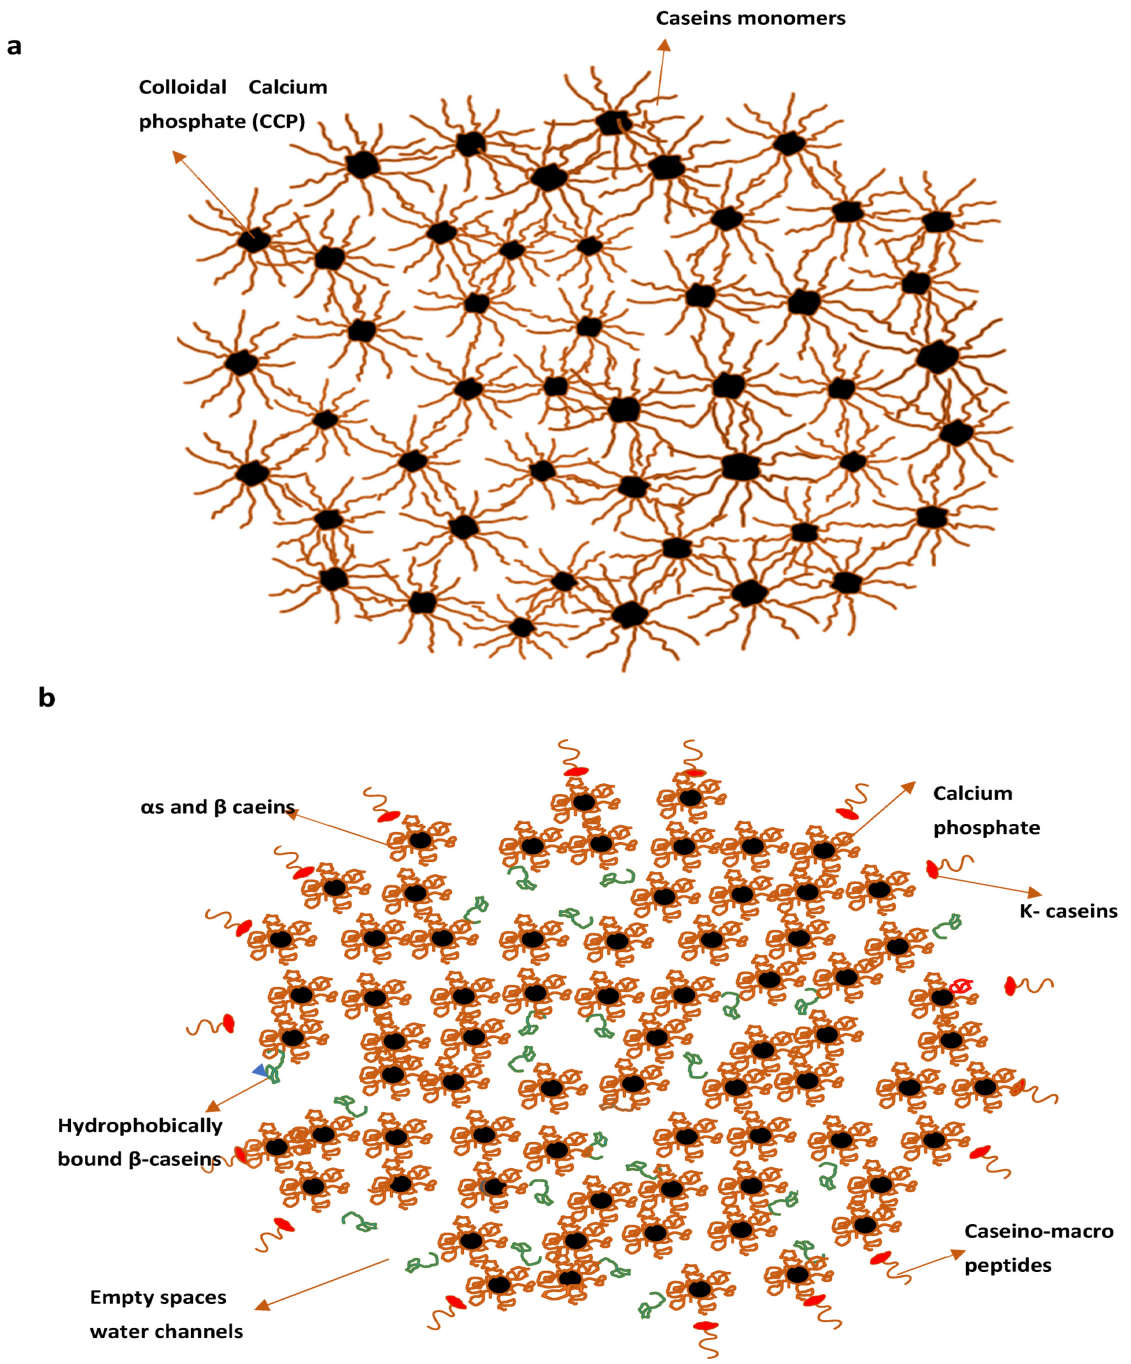
Figure 3. Casein micelles model by Holt ( a ) Casein micelles model by Dalgleish ( b ). Reproduced with permission from [Dalgleish, D.G.], [On the structural models of bovine casein micelles—Review and possible improvements], [Soft Matter], (2011).